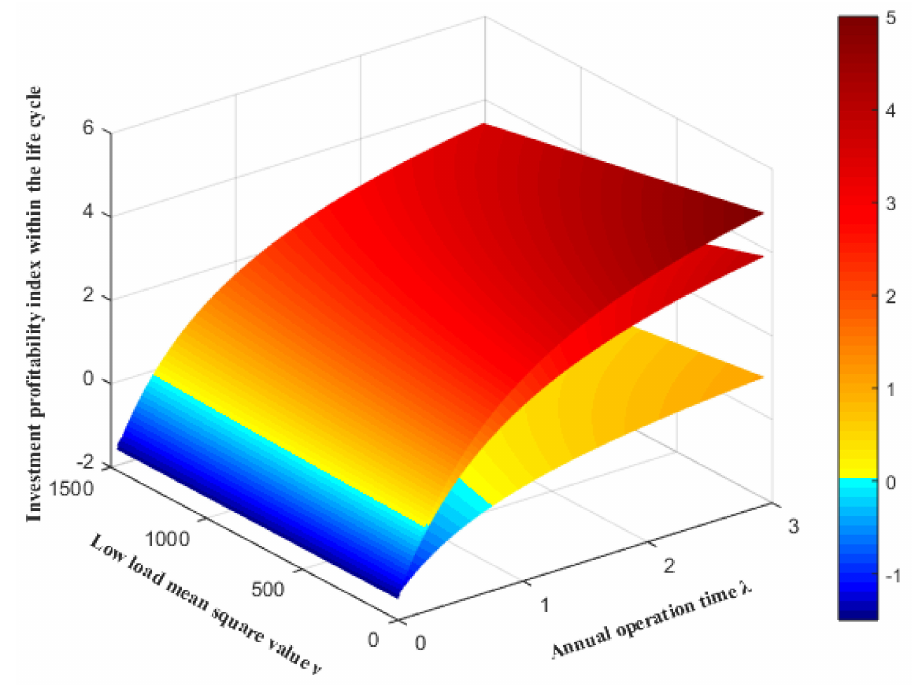
Figure 12. Investment profitability index F E within the life cycle with the change of index ν and λ